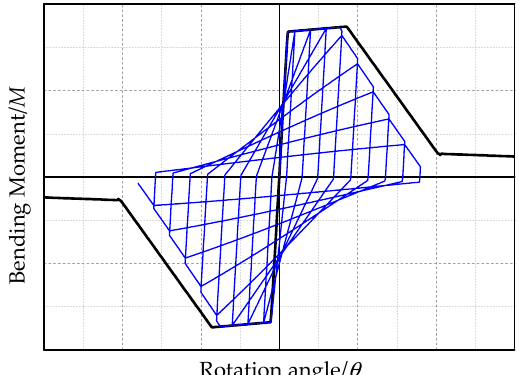
Figure 6. Hysteretic curve of the maximum pointing IMK model.